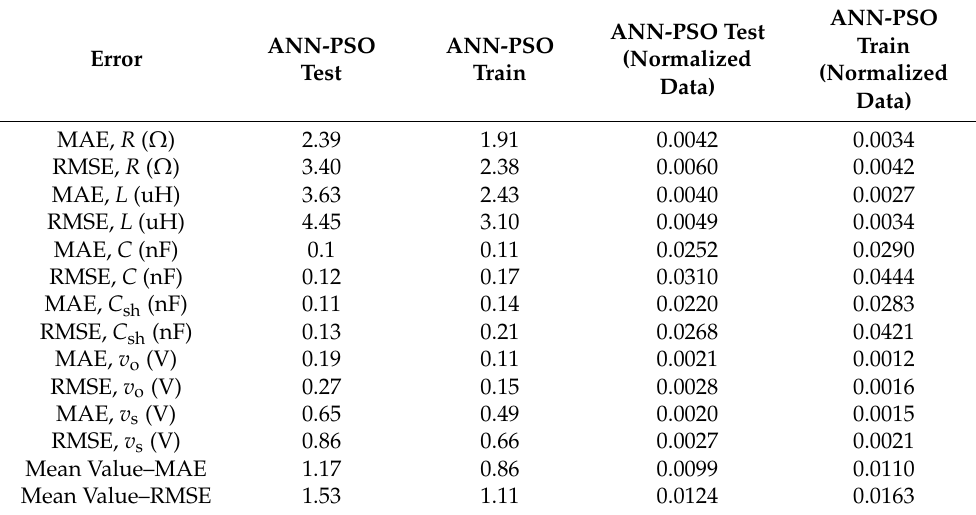
Table 5. Summary of the results of the final proposed ANN–PSO network.